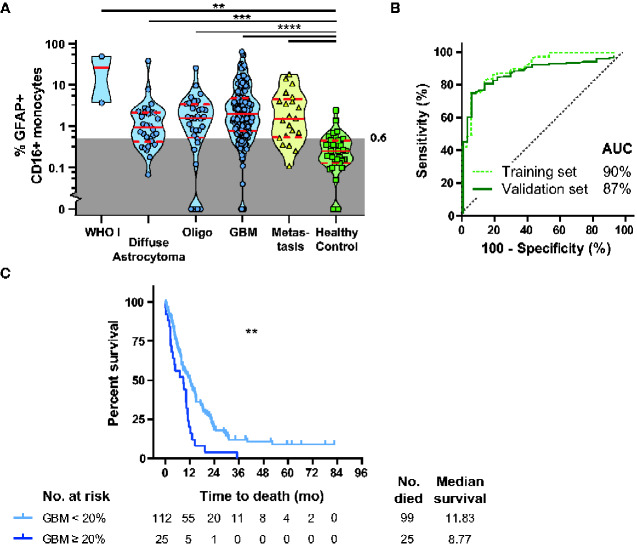

Distribution of GFAP+CD16+ monocytes in blood in brain lesions versus healthy controls and relation to OS in GBM patients. (A) Violin plot with median, quartiles and individual percentages of GFAP+CD16+ monocytes in blood of patients with different types of glioma, brain metastasis, other brain tumours and healthy controls (Kruskal–Wallis). (B) ROC curve with area under the curve for presence of a brain lesion, with GFAP+CD16+ monocytes as predictor in the training set (green dotted line (N = 82) and validation set (dark green line, N = 157). (C) Survival plot of GBM patients with GFAP+CD14−CD16+ monocytes below (light blue) or over 20% (dark blue) of GFAP-positivity. Ticks mark censored cases, Log-rank test. AUC = area under the curve; Oligo = oligodendroglioma; ROC = receiver operating characteristic; ** P < 0.01, *** P < 0.005, **** P < 0.001.